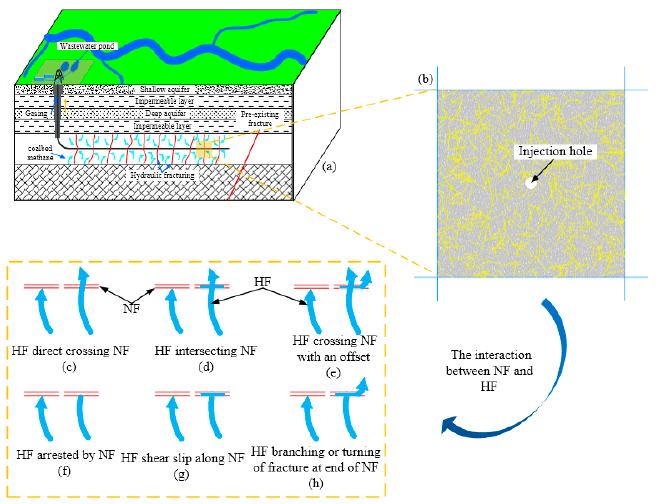
Figure 1. Geometry of a hydraulic fracture network (HFN) depicting various scenarios of interaction with natural fractures (NFs).